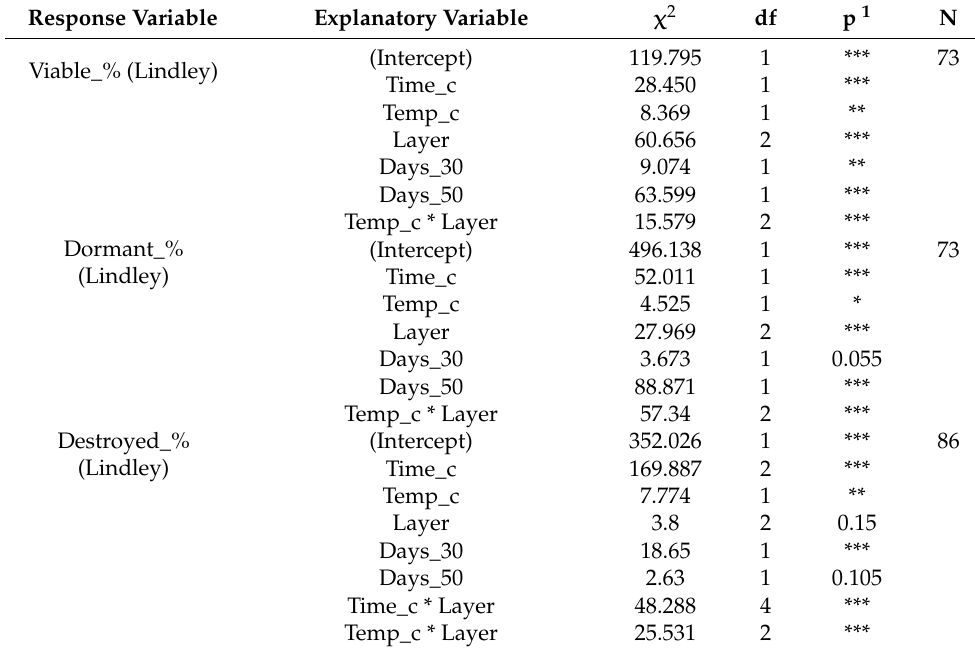
Table 2. Results from generalized linear mixed models used to determine the effects time, temperature and layer on the proportion of destroyed, dormant and viable L. polyphyllus Lindl. seed after composting processes.